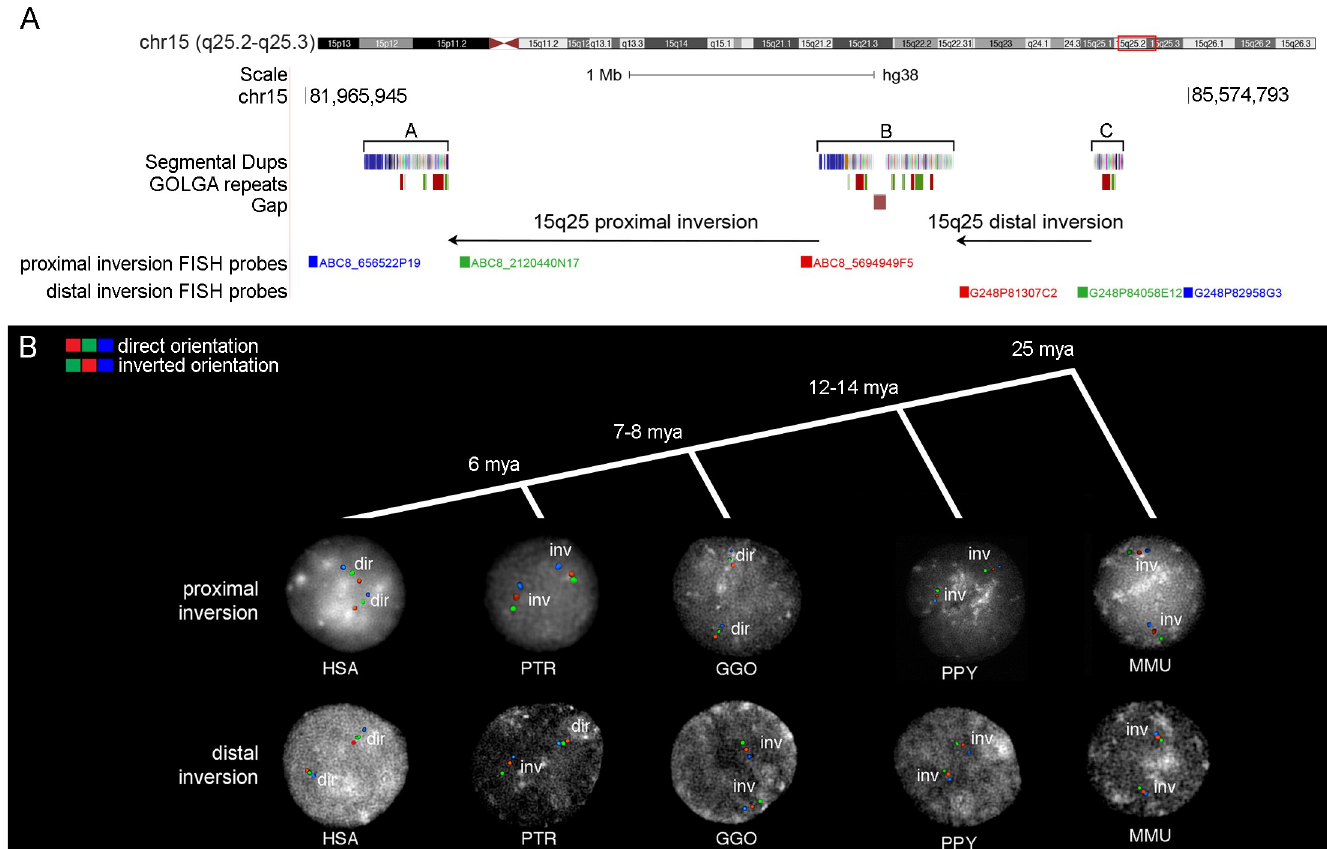
Fig 1. Experimental validation of genomic inversions at 15q25. (A) UCSC Genome Browser view of the 15q25 region. Segmental duplication blocks A, B and C are shown with colored boxes. GOLGA repeat locations from blat analyses of GOLGA2P10 and GOLGA6L5P are depicted with green and red boxes mapping on the plus or minus strand, respectively. Proximal and distal tested inversions are shown with black arrows and fosmid clones used for FISH experiments on interphase nuclei are indicated with colored blocks followed by the fosmid names. Segmental duplication colors show the ancestral origins of duplications based on comparison with mammalian groups assigned by DupMasker [76]. (B) FISH results on interphase nuclei for proximal and distal inversions in each analyzed species. The color order indicates probes relative orientation, with red-green-blue signals showing haplotypes in direct orientation and green-red-blue signals showing inverted haplotypes. FISH analyses of the proximal inversion show that macaque, orangutan, and chimpanzee are all inverted when compared to the human reference genome orientation, while all gorillas are in direct orientation. The distal inversion is polymorphic within the chimpanzee population, while all the other species are inverted in the homozygous state when compared to human. Timing of species divergences is also shown at the top (mya = million years ago). HSA = Homo sapiens ; PTR = Pan troglodytes ; GGO = Gorilla gorilla ; PPY = Pongo pygmaeus ; MMU = Macaca mulatta .